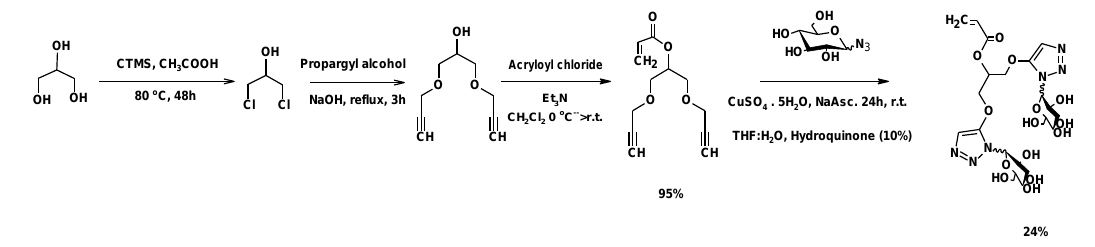
Figure 26. Synthesis of bis-triazol monomers from glycerol.